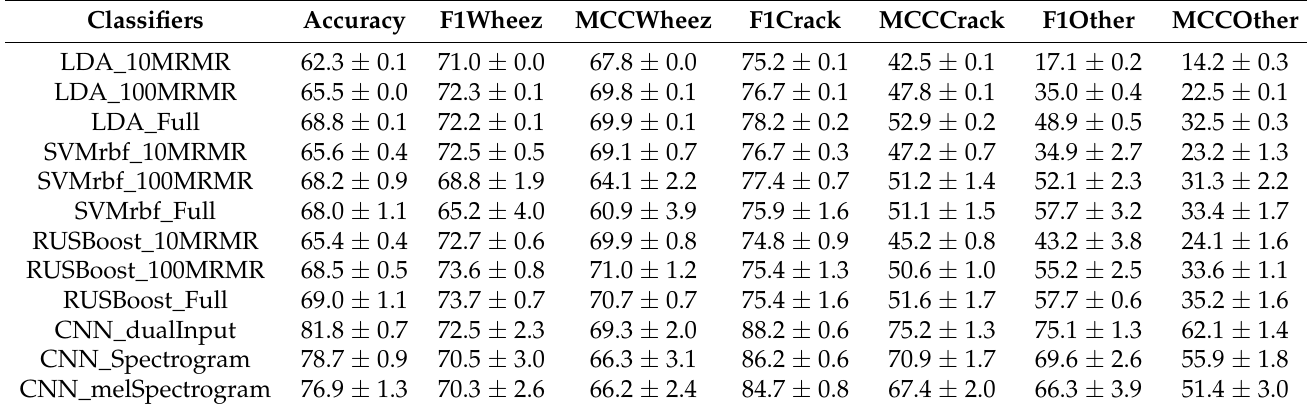
Table 14. Performance results obtained with 3 classes (crackle vs. wheeze vs. other)—training: variable duration; testing: variable duration.